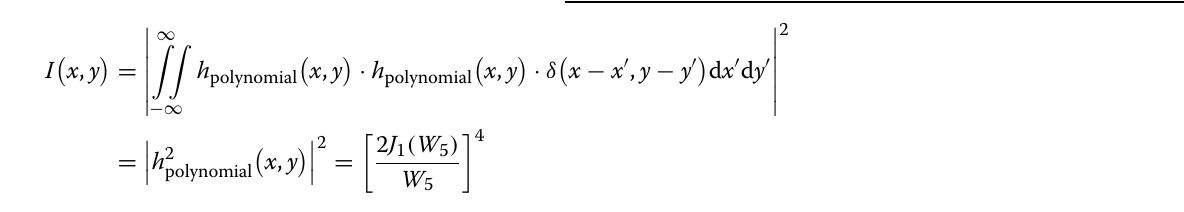
analytical solution represented by Eq. (5) is plotted in Fig. 6 and compared with uniform circular aperture. In the computation, it is assumed that λ 500 nm and the = NA 0.5. = Color image corresponding to the second model of polynomial aperture showing ten concentric layers of B/W polynomial distribution where the center is dark. The layers from the center are 0, ρ 8 , 0, ρ 6 , 0, ρ 4 , 0, ρ 2 , 0, ρ